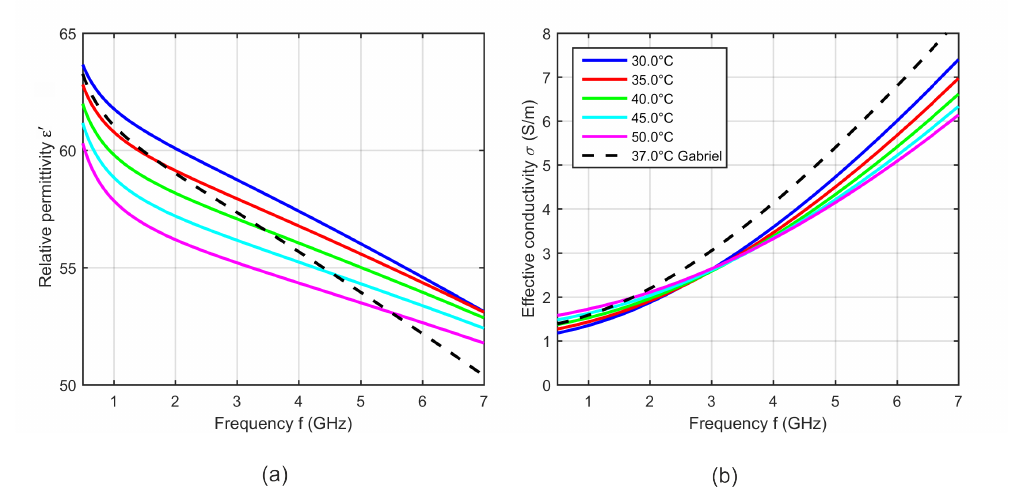
Figure 17. ( a ) Relative permittivity and ( b ) effective conductivity of porcine blood as a function of frequency at different temperatures. Black curves show the dielectric properties of blood reported by Gabriel [31] at 37 ◦ C.